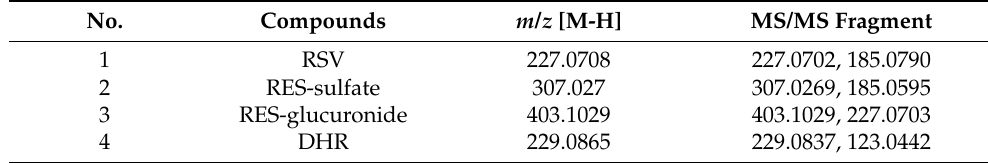
Table 1. List of resveratrol metabolites identified with LC-MS.